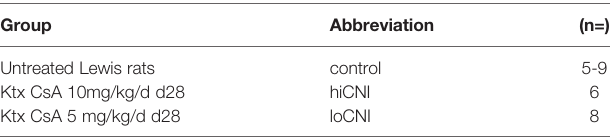
TABLE 1 | Experimental